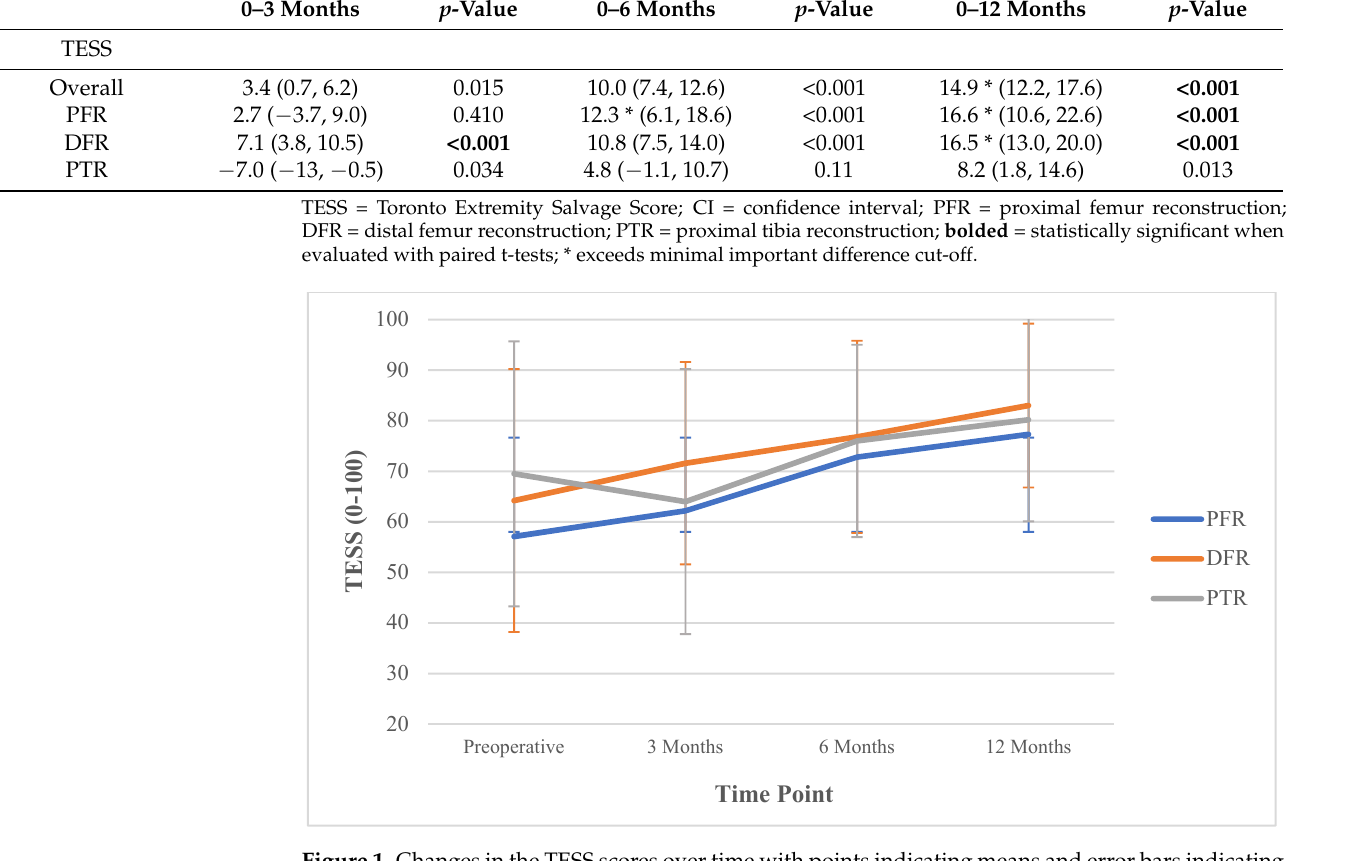
Figure 1. Changes in the TESS scores over time with points indicating means and error bars indicating standard deviations. PFR: proximal femur reconstruction, DFR: distal femur reconstruction, PTR: proximal tibia reconstruction. Table 3. TESS change scores over time.